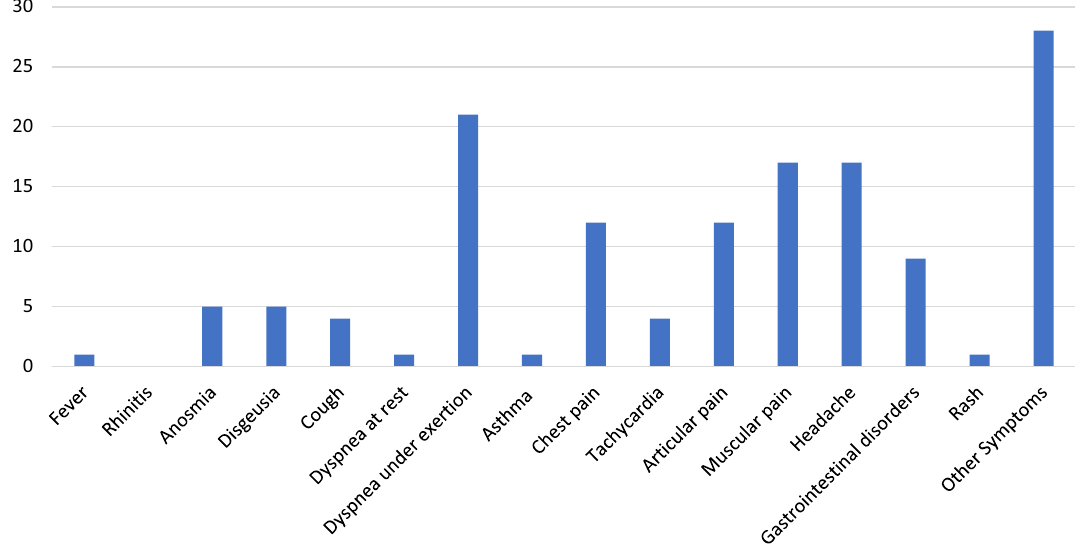
Figure 1. Persisting symptoms reported at 8 weeks or more follow-up evaluation, using the ISARIC assessment tool (supplementary materials). Y-axis refers to numbers.